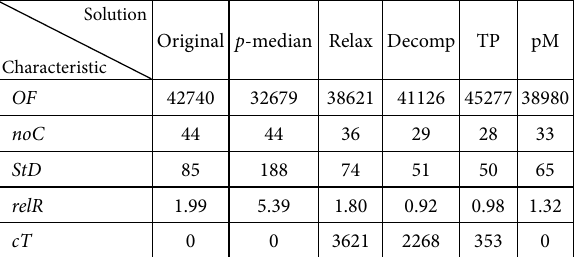
Table 9. Comparison of the results for the region PO Solution